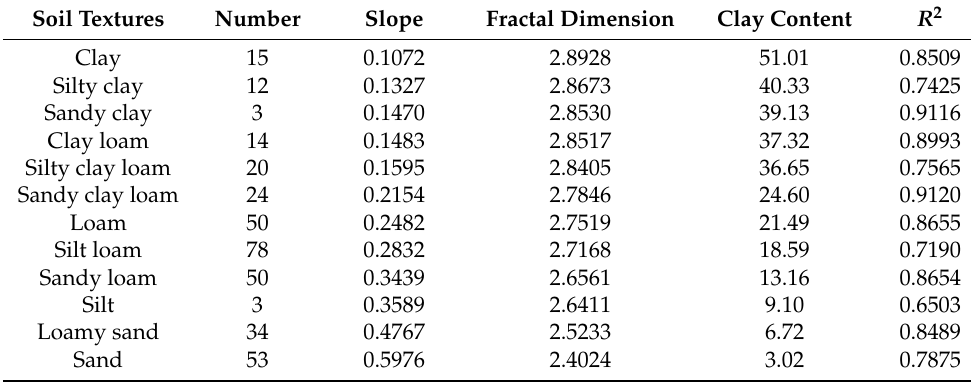
Figure 1. Fitting relationships between log ( M ( r < R )/ M T ) and log( R / R L ) for all soil textures in UNSODA 2.0. Table 2. Fractal dimension ( D 1 ) values of soils with different